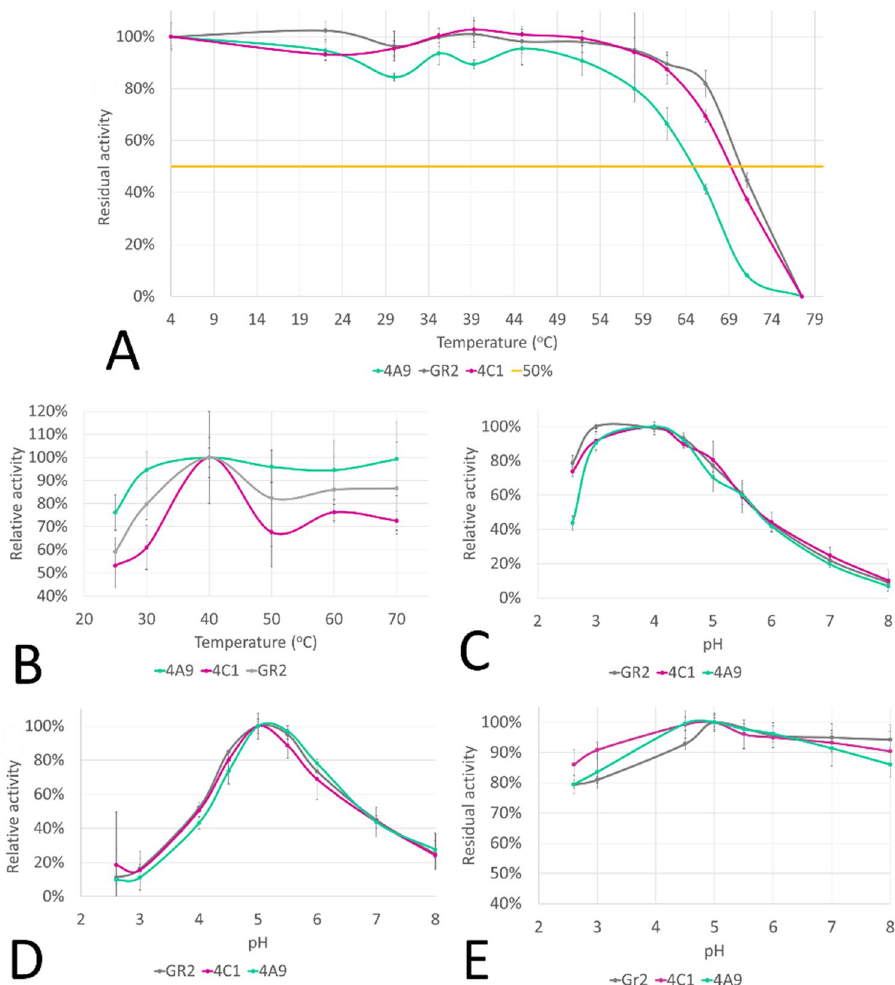
Figure 5. Characterization of 4A9 laccase mutant variant: ( A ) thermostability profiles, ( B ) activity in temperature, ( C ) activity in pH for ABTS, ( D ) activity in pH for DMP, ( E ) stability in